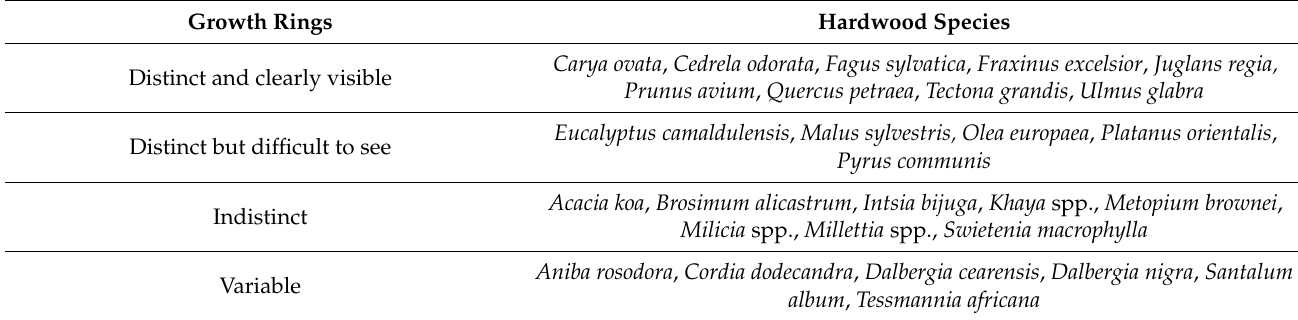
Table 6. Examples of species for different growth rings’ occurrence and visibility.